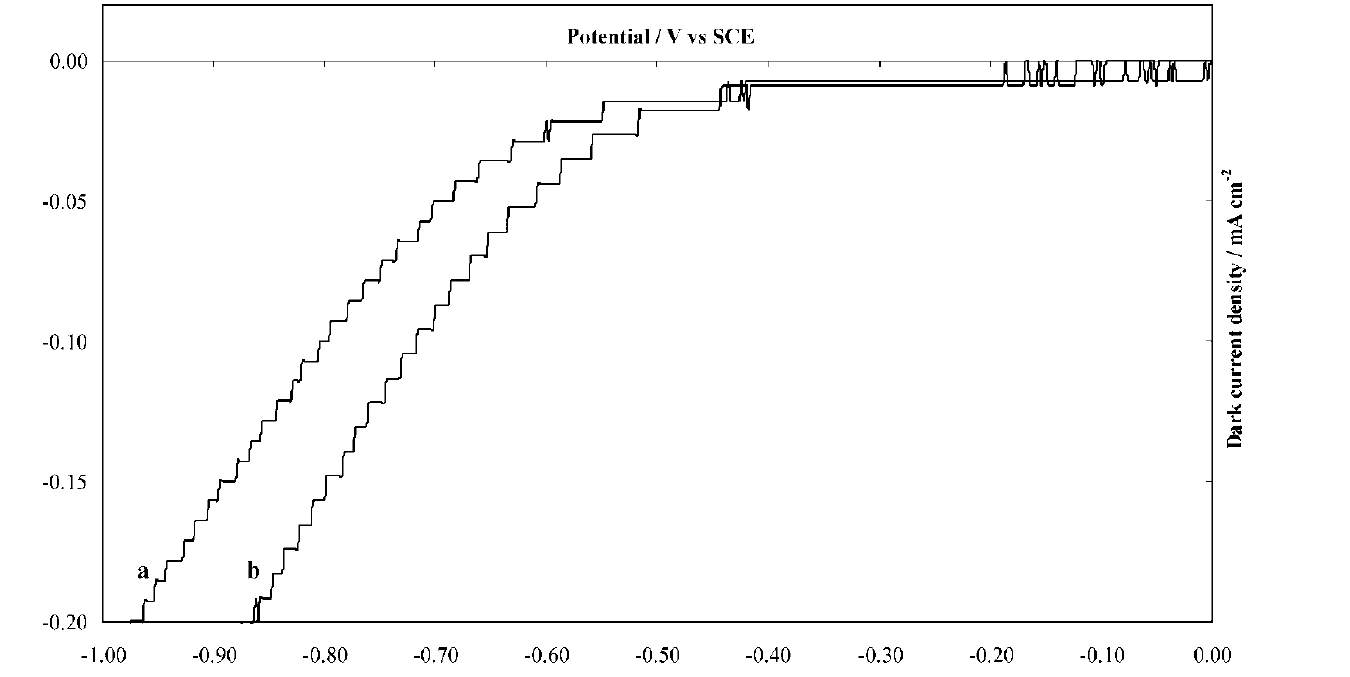
FIGURE 6 Dark J – V plots of (a) slowly cooled and (b) quenched n -Si from 700 (cid:1) C. All J – V measurements were conducted in water = LiClO 4 = K 4 [Fe(CN) 6 ] = K 3 [Fe(CN) 6 ] at 25 (cid:1)